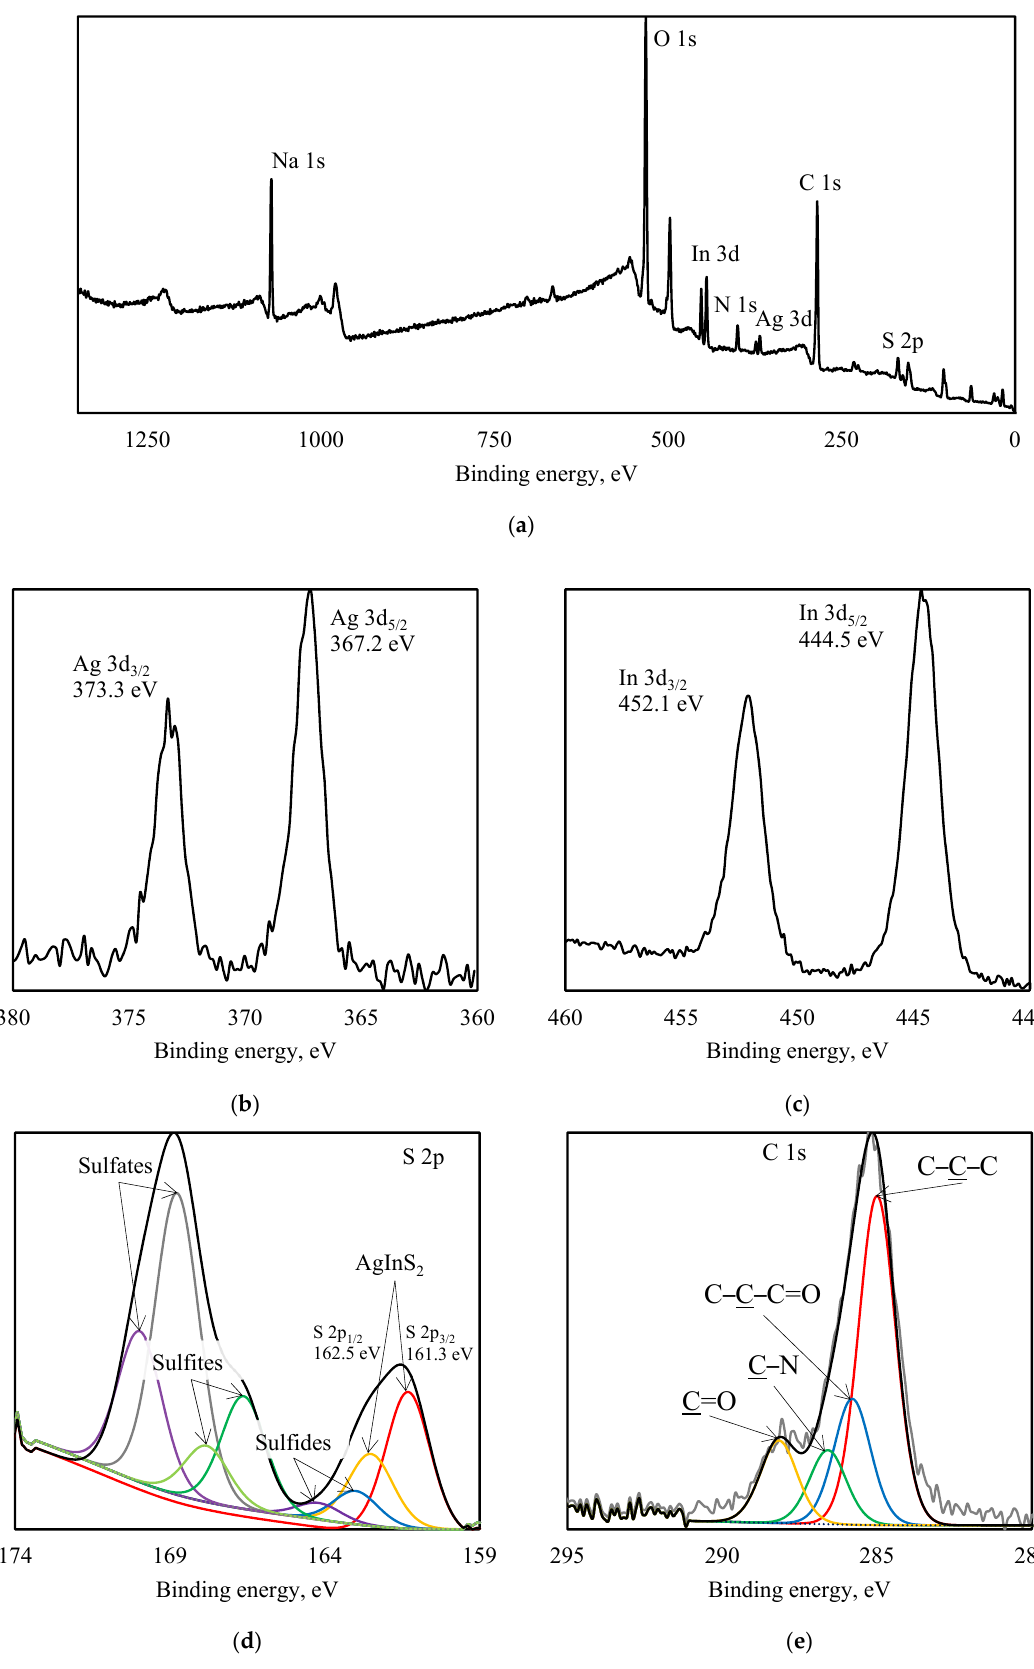
Figure 2. XPS spectra of PVP-capped AgInS 2 QDs: survey ( a ), Ag 3d ( b ), In 3d ( c ), S 2p ( d ), C 1s ( e ).